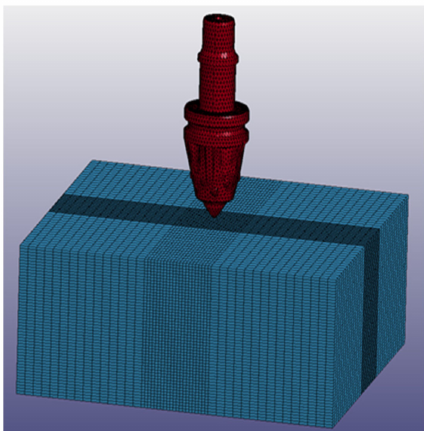
Figure 3. Drill tooth dynamic rock-breaking simulation